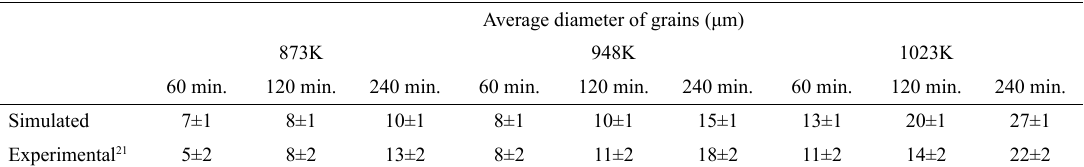
Table 4: Average grain diameters obtained in the simulation, in microns, compared with the experimental values obtained after 60, 120 and 240 minutes at each heat treatment temperature. Average diameter of grains (μm) 873K 948K 1023K 60 min. 120 min. 240 min. 60 min. 120 min. 240 min. 60 min. 120